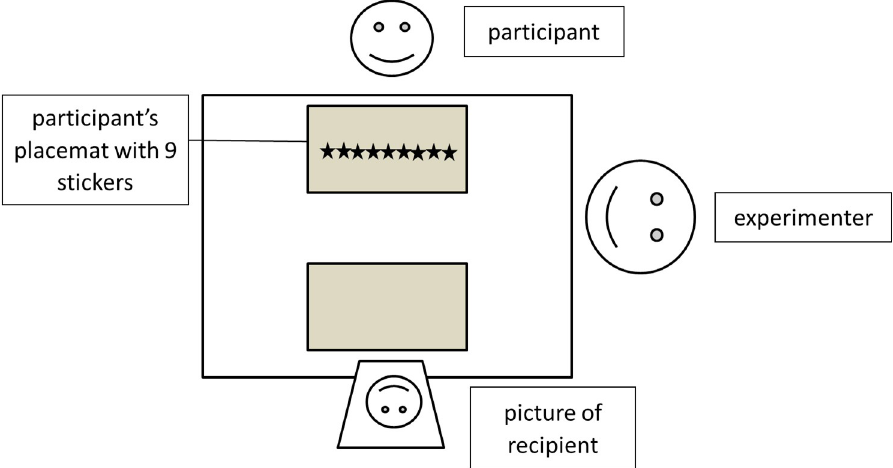
Fig 1. Set-up of the study. The gender of the recipient child on the picture matched that of the